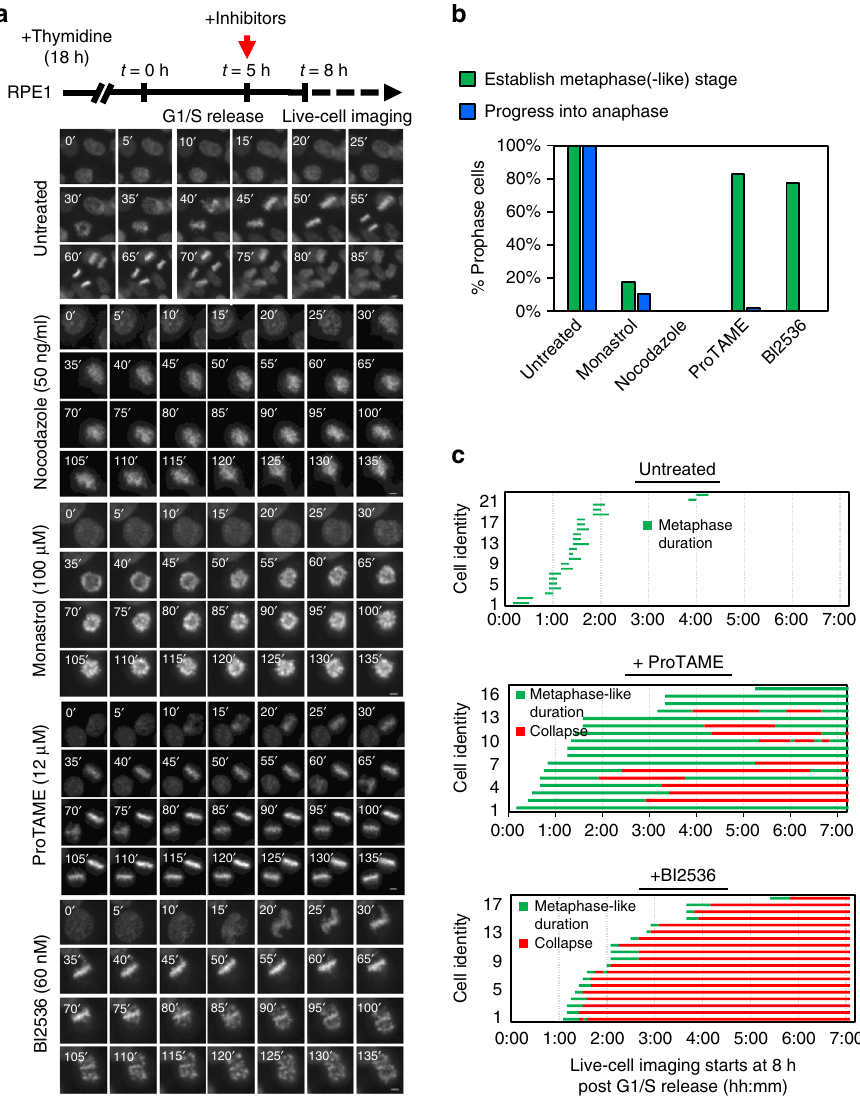
Fig. 1 PLK1 inactivation causes metaphase collapse. a Experimental outline and time-lapse imaging examples showing the mitotic progression of RPE1 cells under the indicated drug treatment. RPE1 cells were arrested in G1/S by a single thymidine block. Five hour post-G1/S-release, the indicated inhibitors were added for another 3 h, followed by live-cell microscopy (started at t = 8 h post-G1/S release). Time-lapse imaging was carried out with a 5-min interval. b Percentages of prophase cells establishing metaphase(-like) alignment and progressing into anaphase under the indicated treatment. A total of 41, 29, 21, 52 and 58 prophase cells were analysed in untreated, monastrol, nocodazole, ProTAME- and BI2536-treated conditions. c The durations of metaphase (-like) and collapse stages (h:min) of RPE1 cells under the indicated treatment. Note: only cells that established a metaphase(-like) stage were measured. 23, 17 and 19 cells were analysed in untreated, ProTAME- and BI2536-treated conditions. DNA was stained by SiR-DNA. Scale bars = 5 μ